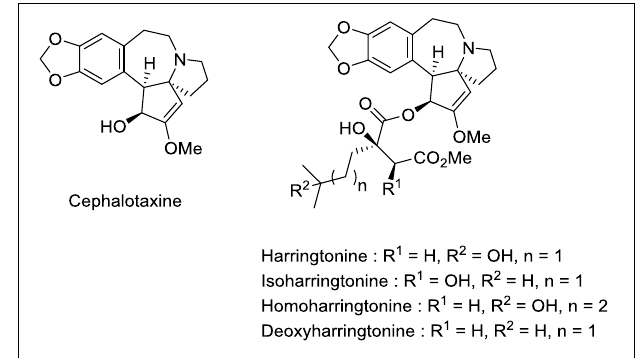
FIGURE 4 | Structures of cytotoxic Cephalotaxus